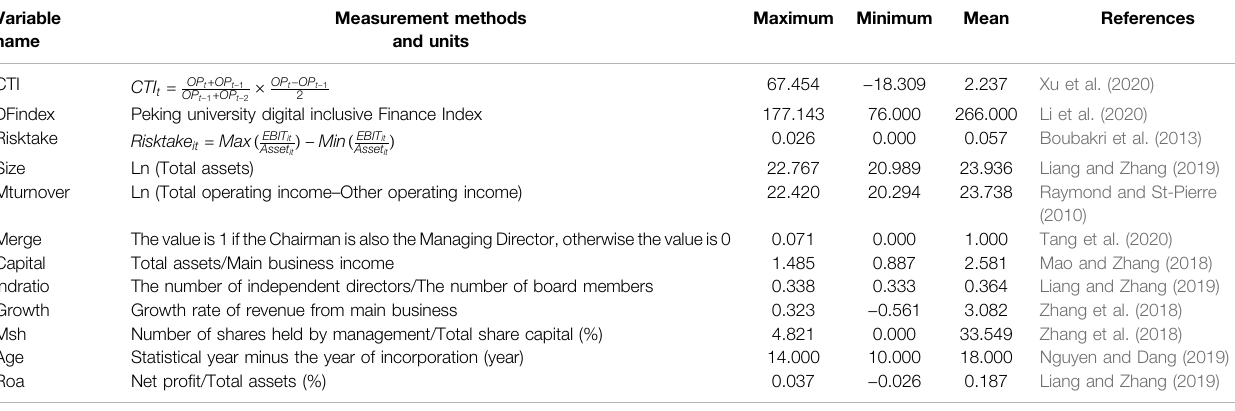
TABLE 2 | Descriptive statistics of variables.